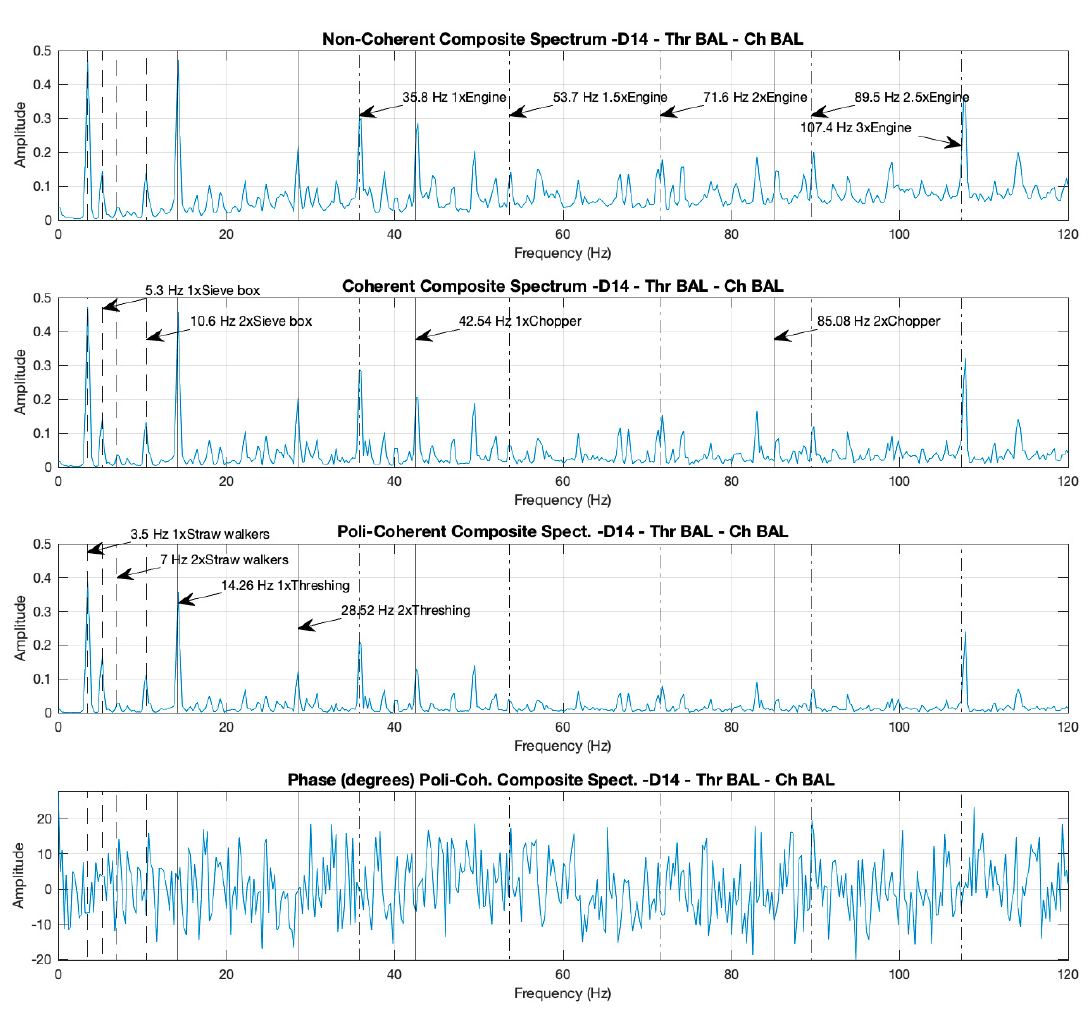
Figure 4. Case D14. Non-coherent, coherent, and poly-coherent composite spectra with the thresher and the chopper both activated and balanced, with the motor at maximum revolutions per minute (RPM).